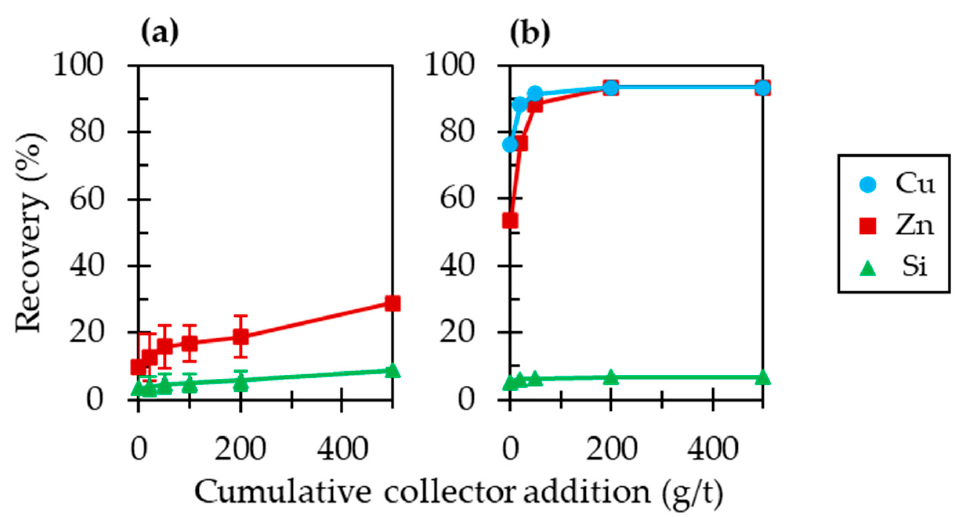
Figure 4. Flotation results of sphalerite in the absence of Zn depressants ( a ) without chalcopyrite and ( b ) with chalcopyrite. Note that the data at 100 g/t of collector in Figure 4b were absent due to the lack of froth amounts for the XRF.